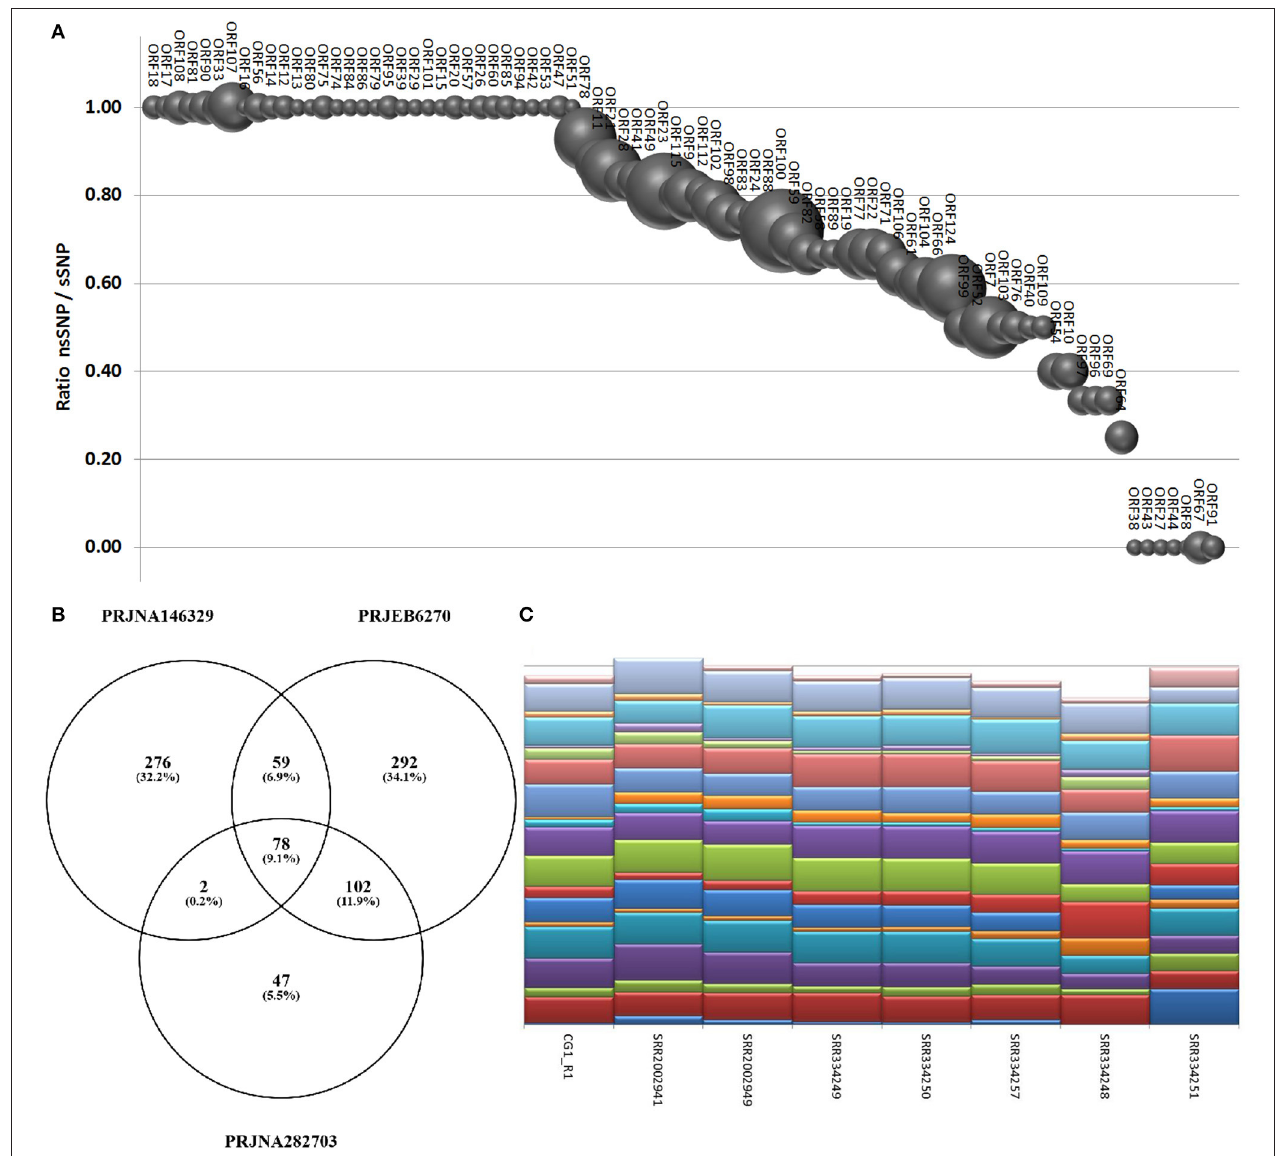
FIGURE 6 | (A) SNPs occurrence in OsHV-1 ORFs. The graph depicts the ratio of nsSNP vs. total SNP for the ORFs presenting at least one variation. Globe size is proportional to the number of SNP for each ORF. (B) Common and exclusive SNPs indicated in the Venn diagram resulted from the comparison of oyster RNA-seq samples grouped by origin. (C) “Genotyping” graph based on 20 polymorphic common OsHV-1 SNPs in the eight samples richest in viral reads (indicated by